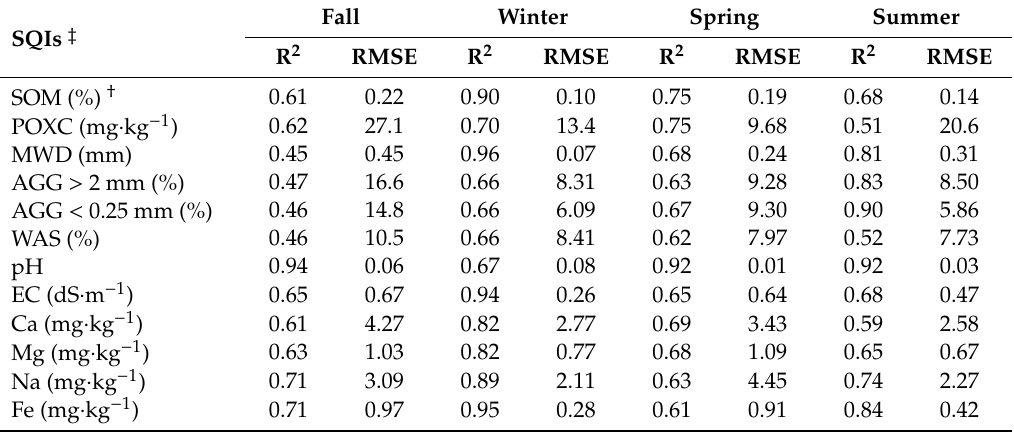
Table7. CalibrationR 2 andRMSEforvisible-nearinfraredspectroscopy(VNIRS)overfourmeasurement seasons at Leyendecker Plant Science Center, Las Cruces, NM (n = 36 for each